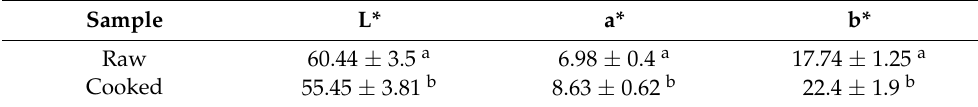
Mean standard deviation based in 17 determinations. Different letters in each column indicate significant difference ( p < 0.05), Tukey range test. L*: luminosity (100: white to 0: black); a* indicate red (+a*) and ( − a*) green shades; b* indicate yellow (+b*) and blue ( − b*)